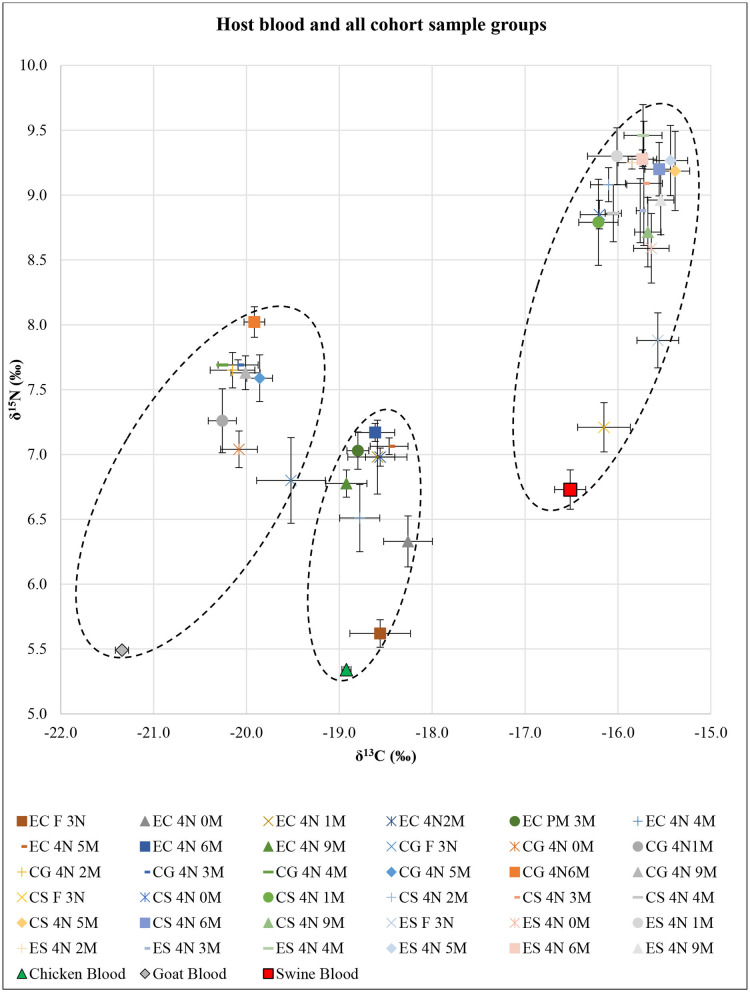
Isotopic results of all Ornithodoros turicata cohort sample groups based on post-molt time (n = 5 each) represented as δ13C and δ15N superimposed over the host blood results. X- and Y-axis error bars represent SEs around means. Dotted oval shapes encircle δ13C and δ15N values for each of the EC, CG, and CS+ES cohorts. EC, exclusively fed on chicken blood; CG, fed on chicken and goat blood; CS, fed on chicken and swine blood; ES, exclusively fed on swine blood; F 3N, third-instar nymph immediately after feeding; 4N 0M, fourth-instar nymph immediately after a molt; 4N 1M−4N 9M, fourth-instar nymph 1 month post-molt to fourth-instar nymph 9 months post-molt.